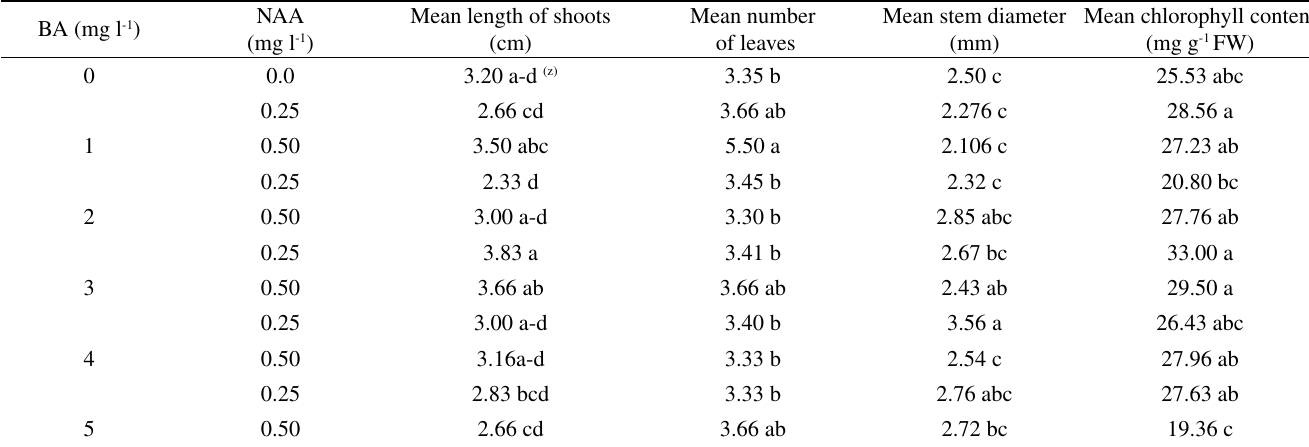
Table 4 - Effects of different treatments on some characteristics of acclimatized ‘Variegated’ plantlets, 60 days after transfer BA (mg l -1 )